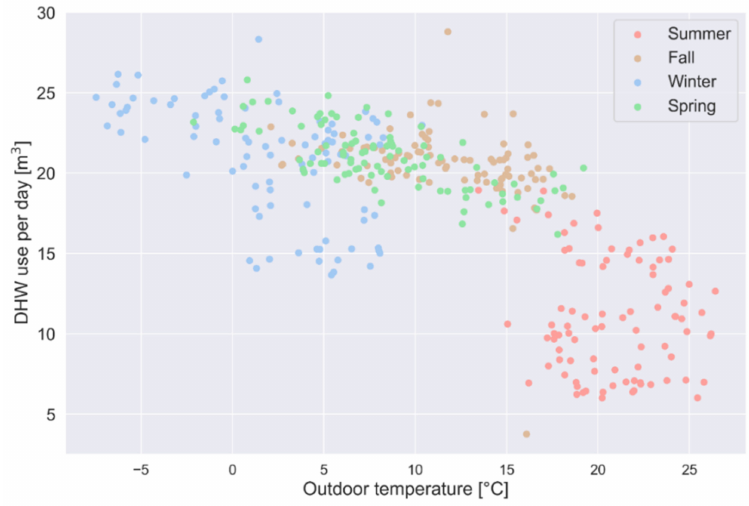
Figure 15. Daily DHW use in the apartments versus the average outdoor temperature.